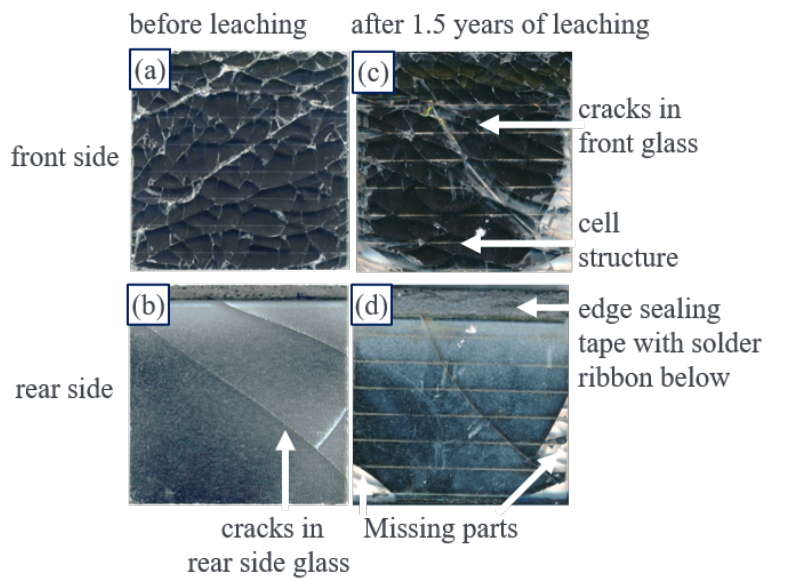
Fractional separation: Figure 4a–d shows photographs of the front and the rear side of a 5 × 5 cm 2 CIGS module piece before and after 1.5 years of leaching: parts of the rear side are separated. Both glasses, the front and the rear side glass, show cracks due to the water jet cutting. Figure 4c shows a photograph of the front side after 1.5 years of leaching in solutions with pH 3. From the front side, a few transparent spots around the edges are visible. From a more detailed look at the back side of the module piece (Figure 4d), it becomes clear that at the transparent spots, parts of the rear side glass are missing, together with the back contact and the active module layers. Therefore, only the transparent front glass remains.